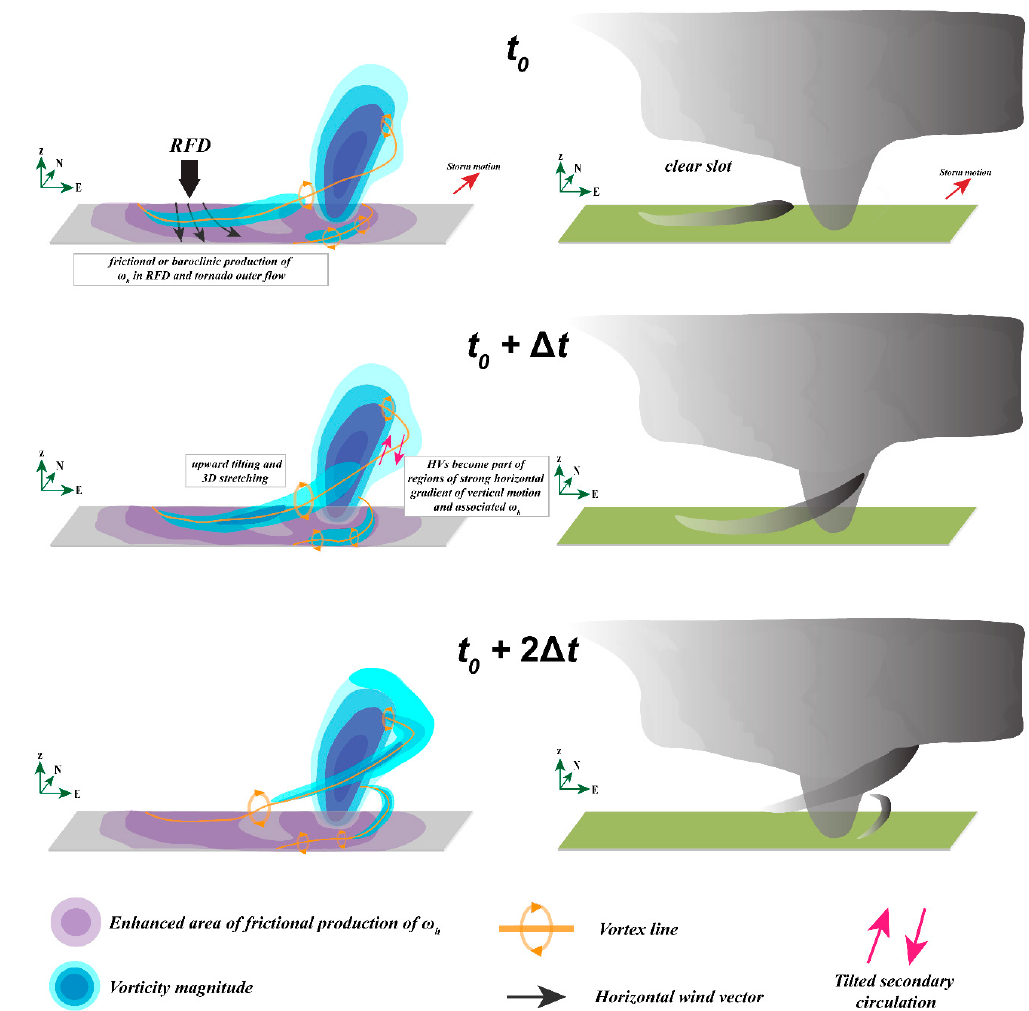
Figure 9. Conceptual model of evolution of HVs in the simulation from initial time t 0 through t 0 + 2 ∆ t , at ∆ t time increments. Left column: 3D vorticity magnitude isosurfaces shaded in blue. The vertically-oriented vortex represents an intensifying or mature tornado while slantwise, detached vortex tubes represent more horizontally-oriented vortices in the periphery of the tornado. Regions of enhanced frictional generation of horizontal vorticity in strong, near-ground horizontal wind embedded in the RFD outflow are shaded in purple. Magenta arrows in the middle panel show the tilted circulation on the forward side of the tornado. Representative vortex lines associated with the HVs are displayed in light orange, with circular arrows indicating their sense of rotation. Strong surface RFD flow is indicated by the curved black arrows. Right column: The cloud field associated with a tornado producing HVs consistent with the vorticity field displayed in the left column and visual observations. The RFD-related clear slot is annotated. The storm is moving to the northeast, as indicated by the red arrow the upper